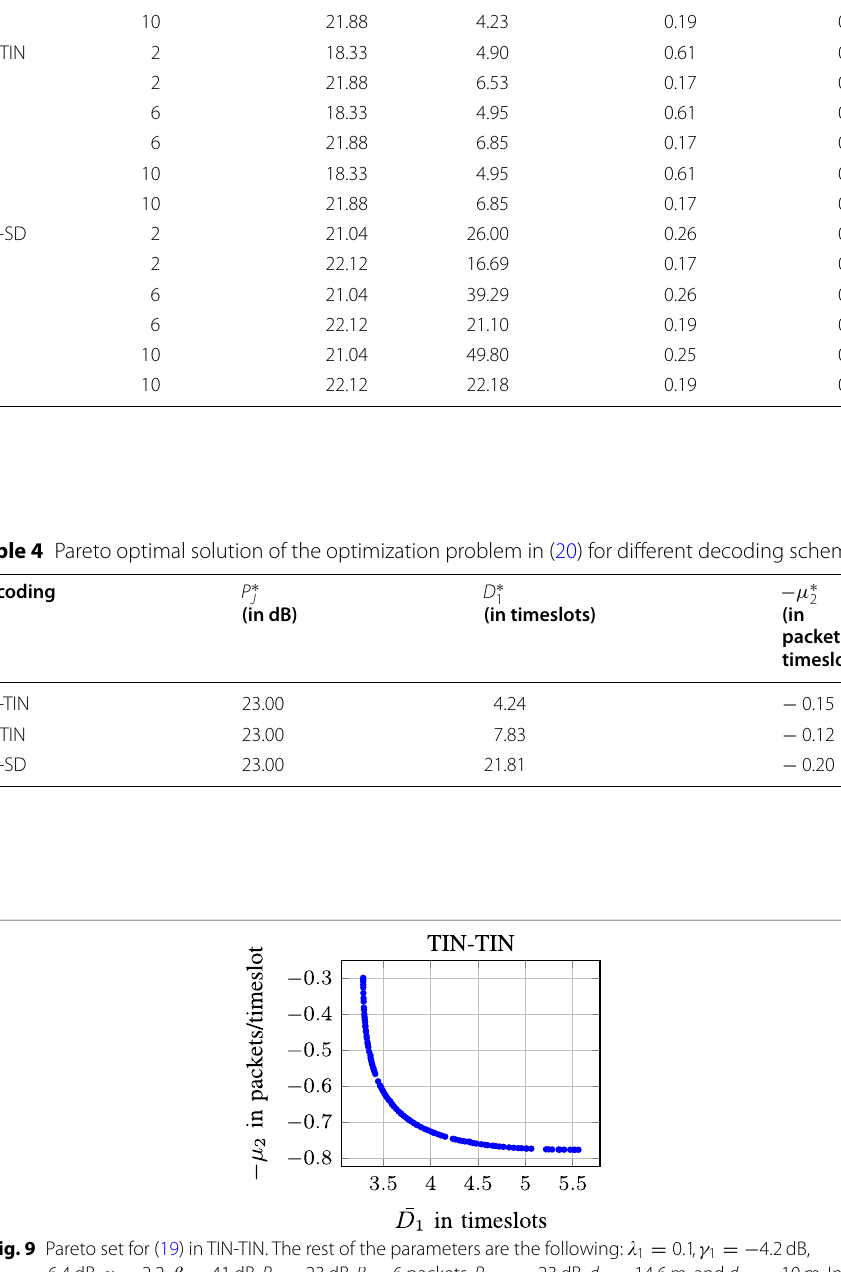
Table 3 Performance in congestion-aware randomized policy when changing B and P 1 Decoding B (in packets) TIN-TIN